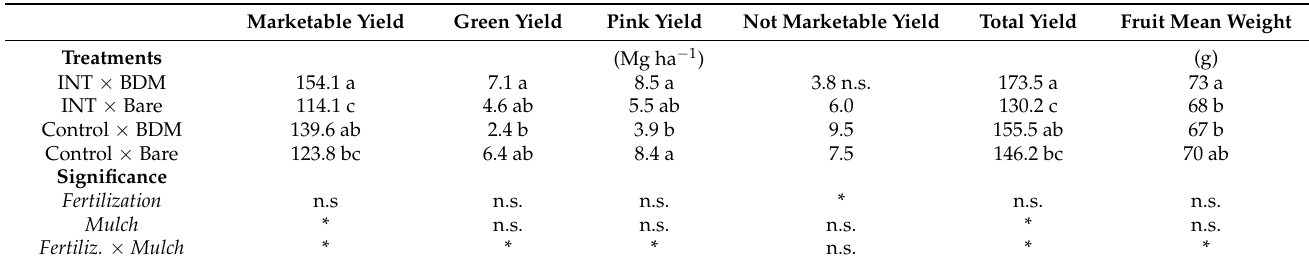
Table 4. Total yield and its composition, fruit mean weight of tomato cv Heinz 5508, in 2017, in relation to different combinations of type of fertilization and soil mulching.